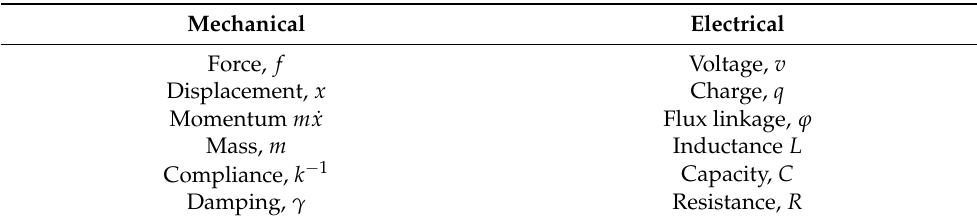
Table 1. Mechanical-electrical analogy.